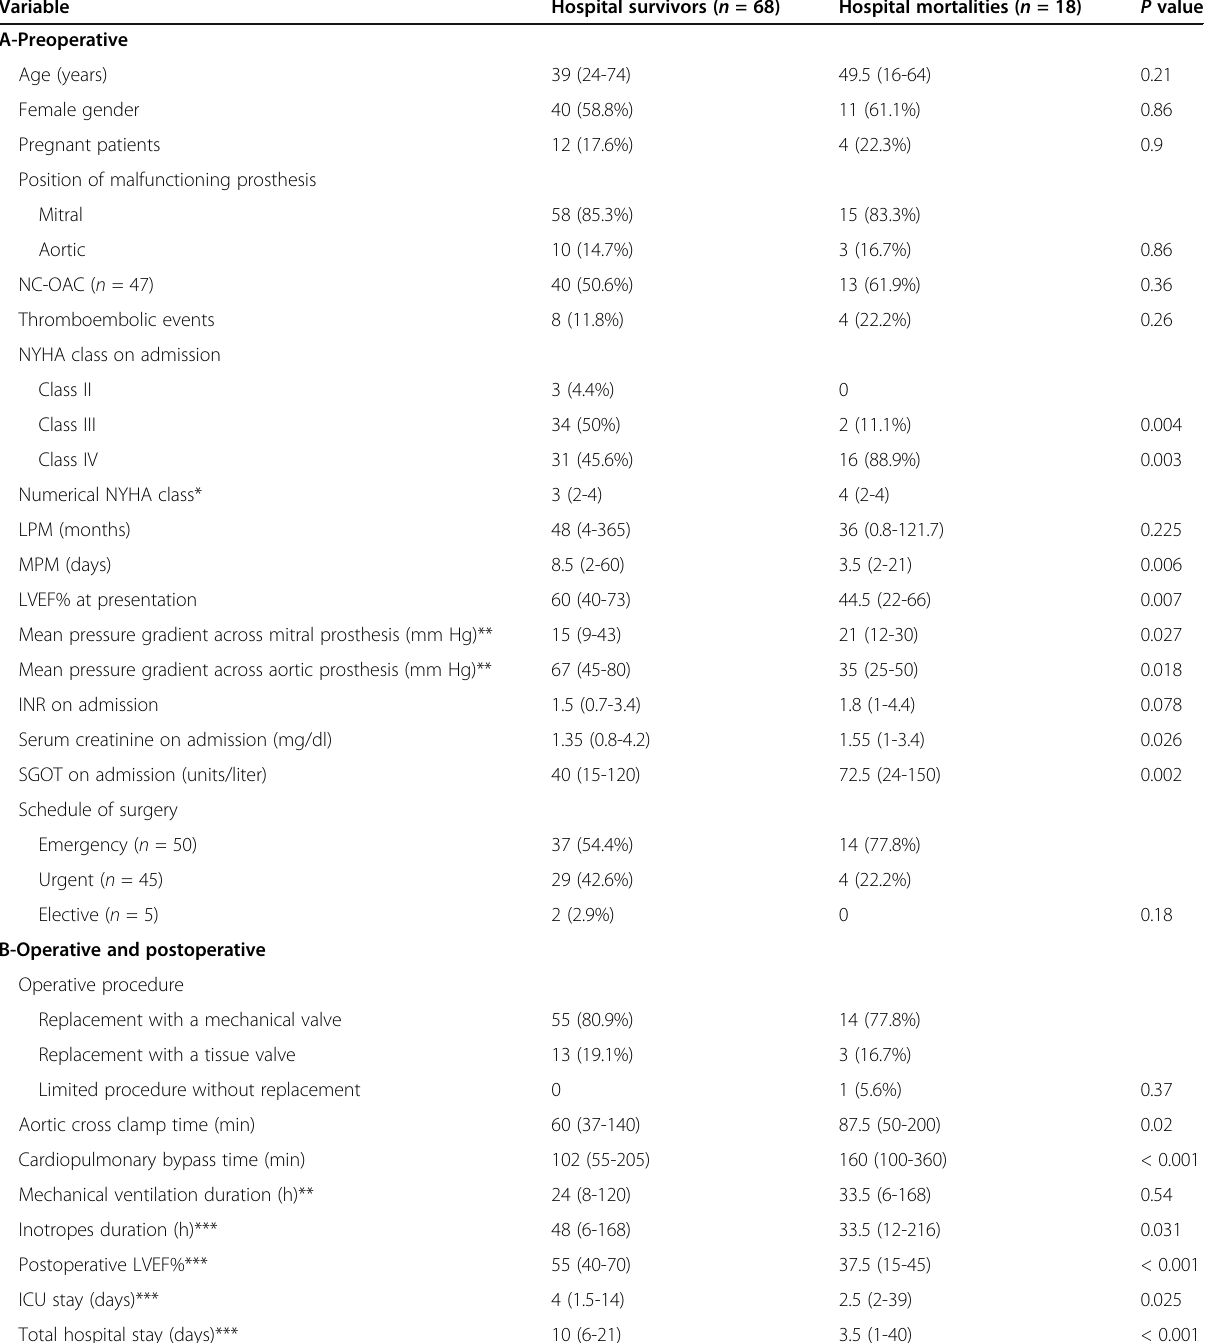
Table 4 Analysis of